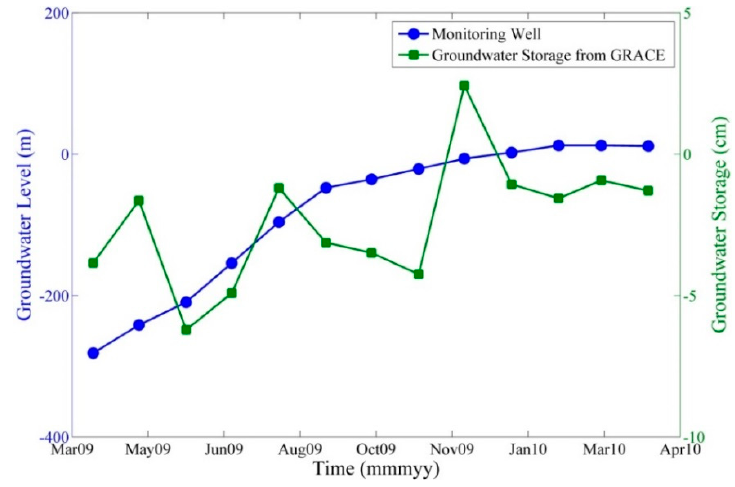
Figure 7. Validation of GRACE results.